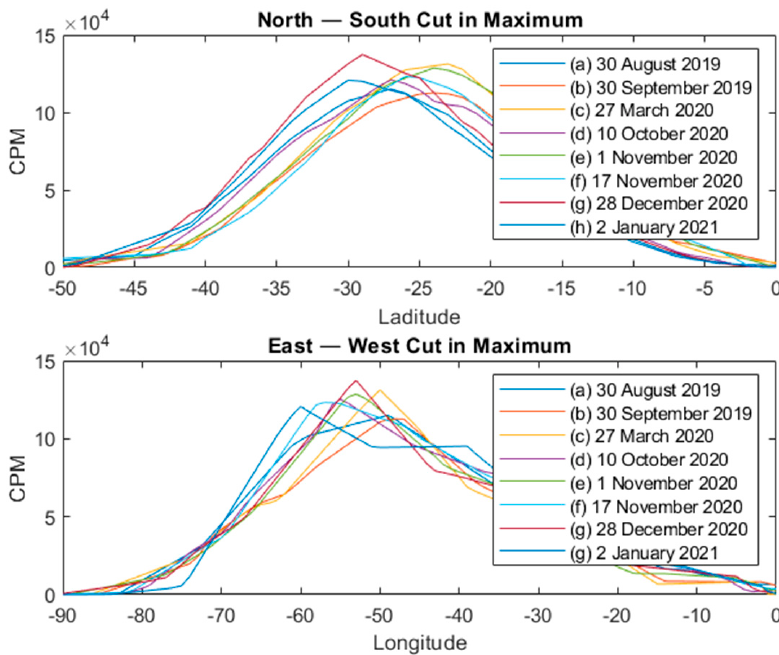
Figure 7. North–south and east–west cross-sections of the SAA radiation field.